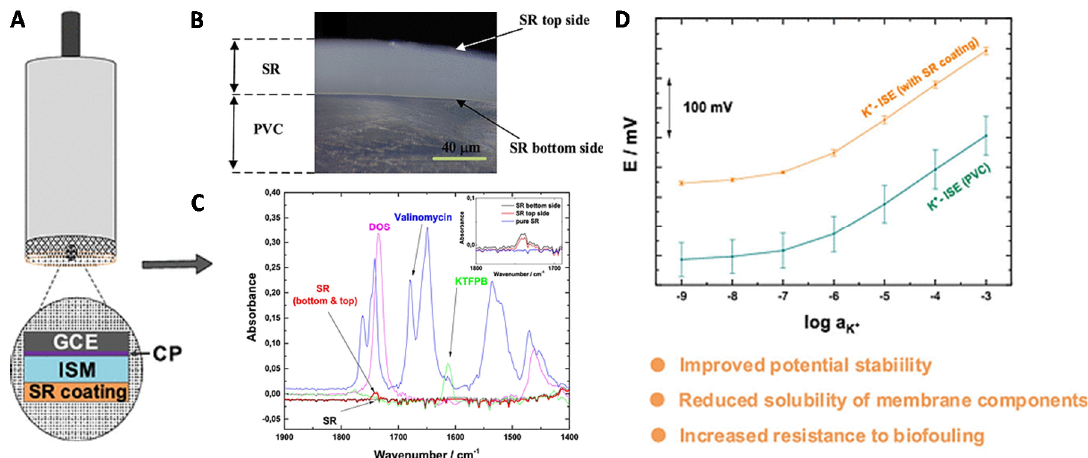
Figure 4. Suppress of the leaking of ISM components. ( A ) A CP-based SC-ISE by coating the silicon rubber (SR) on the ISM layer. ( B ) A photograph of the SR on the poly(vinyl chloride) (PVC)-based ISM. ( C ) Fourier transform infrared (FTIR) spectra analysis of the SR layer (bottom and top) in comparison with standard ISM components. The ISM components were observed in both bottom and top SR (typical dioctyl sebacate, DOS). ( D ) The K + -response of SR-coated SC-ISEs compared with an uncoated one. Reprinted with permission from [49], Copyright (2019) American Chemical Society.